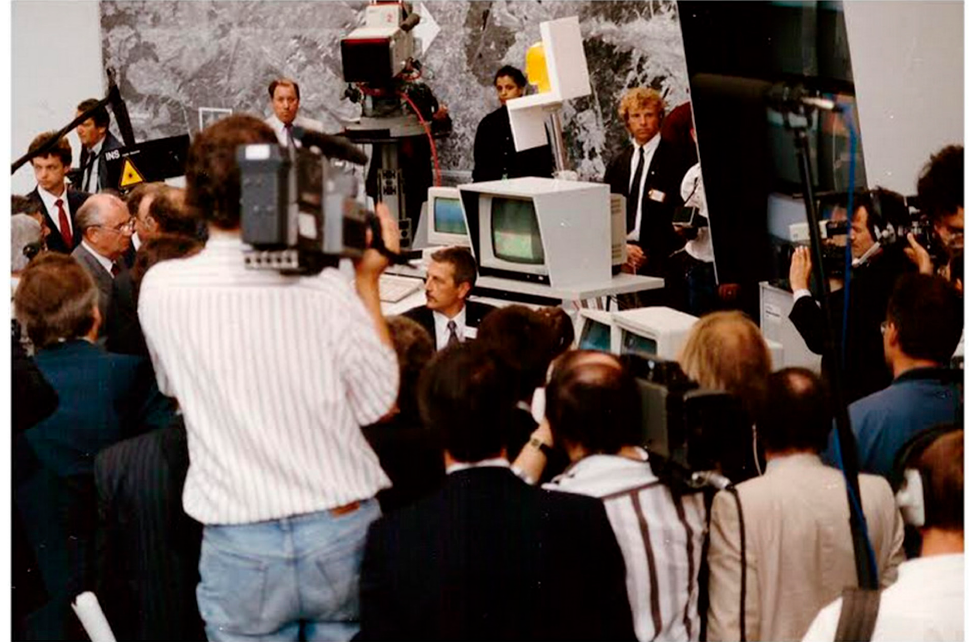
Figure 2. 1989—Institute of Nuclear Technology and Energy Systems (IKE) experts show Mikhail Figure 2. Gorbachev (then president of the UDSSR) a simulation of the atmospheric dispersion of radioactive materials from the Chernobyl accident site produced by the ABR-KFÜ system (Courtesy of Dr. Walter Scheuermann).